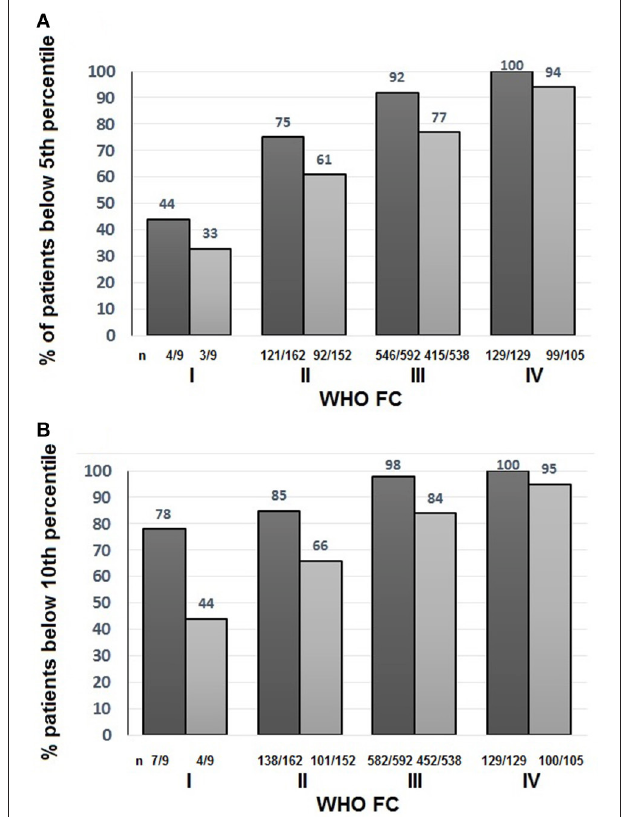
FIGURE 4 | Percentage of patients with Incremental shuttle walk distance percent predicted (ISWD%pred) and Diffusing capacity across the lung for carbon monoxide percent predicted (DLco%pred) less than 80% predicted in (A) All patients (B) Patients with congenital heart disease excluded by World Health Organization Functional Class (WHO FC).